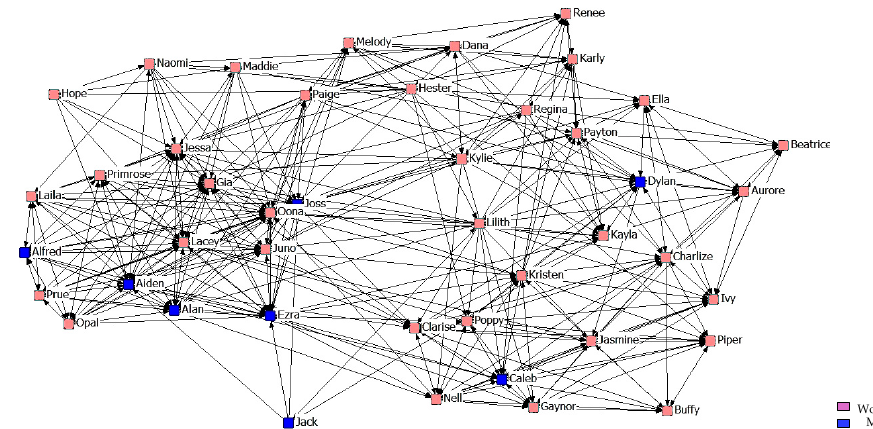
Figure 2. Graph of the second year Support Network.